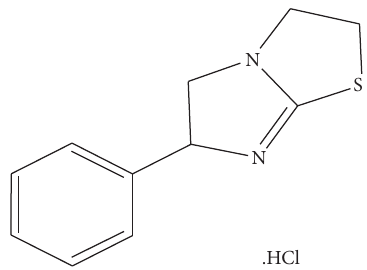
Figure 1: Chemical structure of levamisole